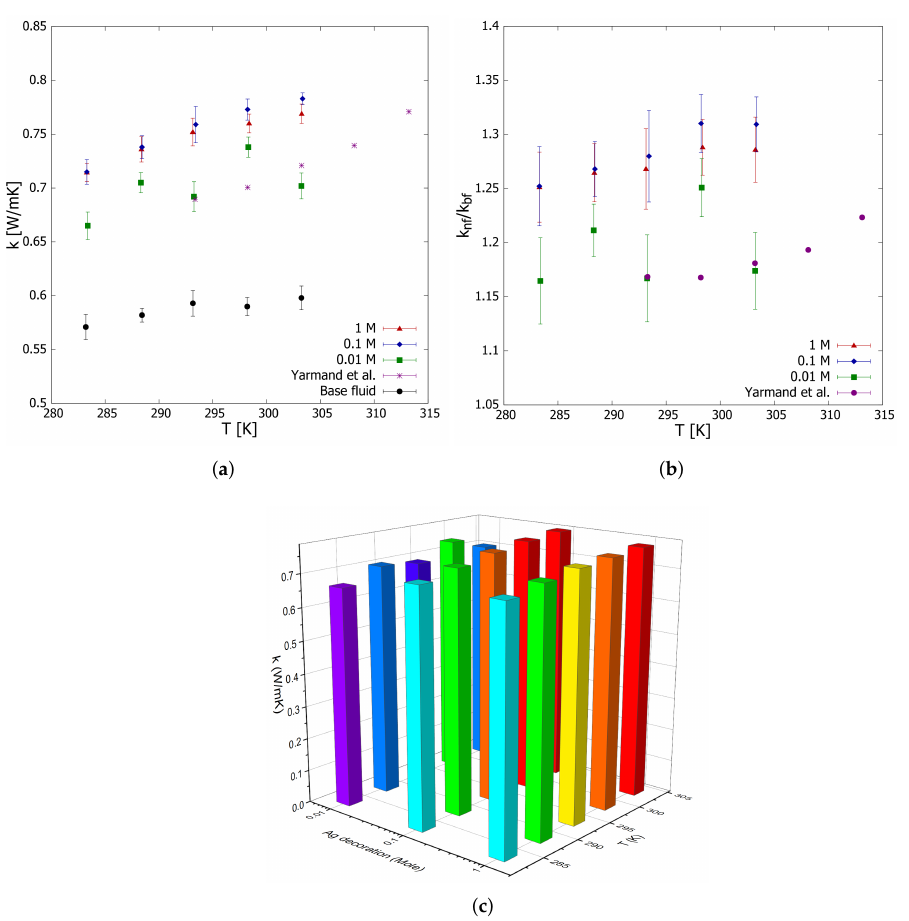
Figure 4. Effective thermal conductivity ( a ), relative thermal conductivity ( b ) and effective thermal conductivity with respect to the Ag decoration and temperature ( c ). The error bars ( a ) correspond to the measurements’ standard deviation and the propagation error ( b ) according to Equation